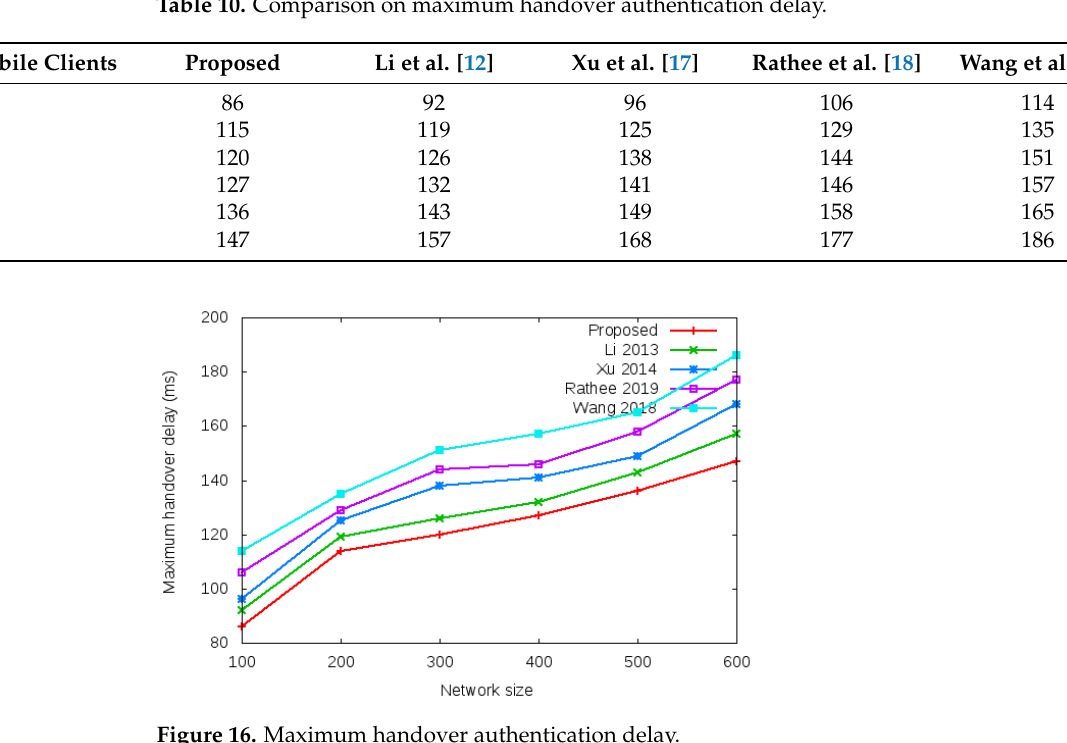
Table 10. Comparison on maximum handover authentication delay.